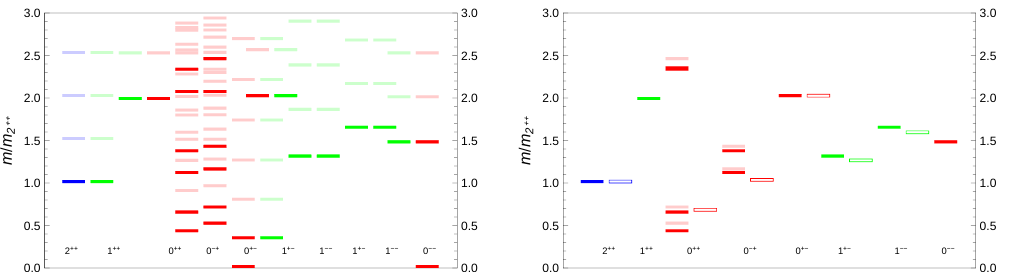
Figure 1 . Full light SU(2) × SU(2) -singlet spectrum of the bosonic states in the Klebanov-Strassler theory (left). The ground states of each supermultiplet are shown in full color, while the excited states are faded. All the mass values are computed in the units of the ground state of 2 ++ . The discrepancy of the 0 ++ [66] and 0 − + [72] sectors is visible. The right plot compares the masses of the ground states in the supersymmetric Yang-Mills sector (filled rectangles) and the ground states in SU( N ) bosonic Yang-Mills, extrapolated to N = ∞ (empty rectangles). In the 0 ++ / 0 − + sector the results of [66] are shown in full color, while that of [72] are faded. States that do not have pairs correspond to hybrid glueballs with no analog in the bosonic theory, except for the heaviest 0 ++ that has not been approached on the